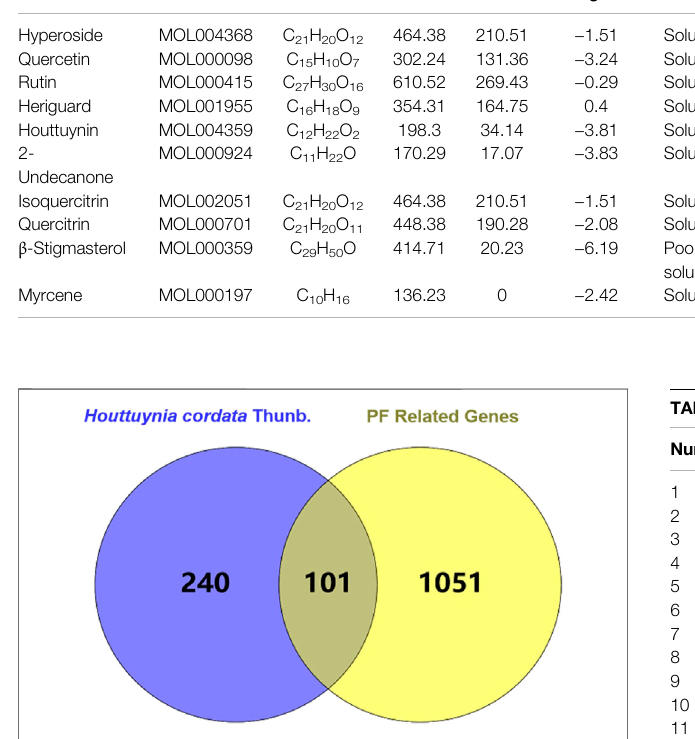
FIGURE 2 | Venn diagram of common gene targets of pulmonary fi brosis and H. cordata .